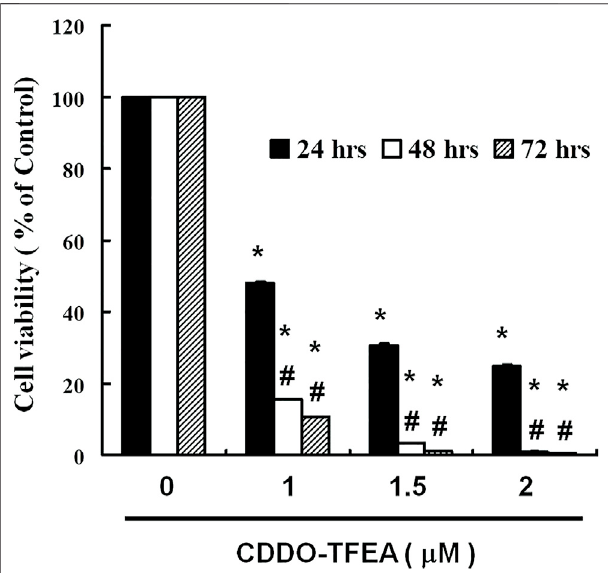
FIGURE 1 | Viability of GBM8401 cells after 24 – 72 h of CDDO-TFEA treatment. CDDO-TFEA mediated the survival of GBM8401 cells by inhibiting proliferation. Cells were treated with increasing doses of CDDO-TFEA for 24 – 72 h in vitro . The survival rate of the treated cancer cells was measured using a PB assay. Results are expressed as percentages of the control, with the control being 100%. All data are reported as means ± standard errors of the mean on the basis of the results of at least three separate experiments. Statistical analysiswasperformed using the t test, with differences between the treatment and control groups (# vs. 24-h treatment) consideredsigni fi cantat p < 0.05,asdenotedby*and#standarderrorsofthe